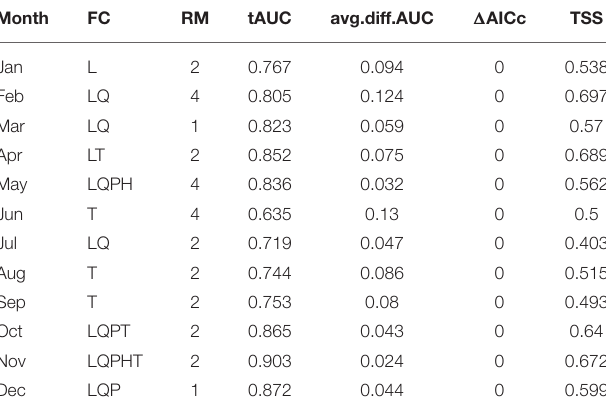
TABLE 2 | Feature classes (FC), regularization multipliers (RM), AUC based on the test set (tAUC), average difference between training and testing AUC (av.diff.AUC), the difference between the sample-size-adjusted Akaike information criterion value (AICc) of the model, and the model with the lowest AICc value ( 1 AICc), and true skill statistic (TSS) of the selected models by month for the monarch butterfly migratory